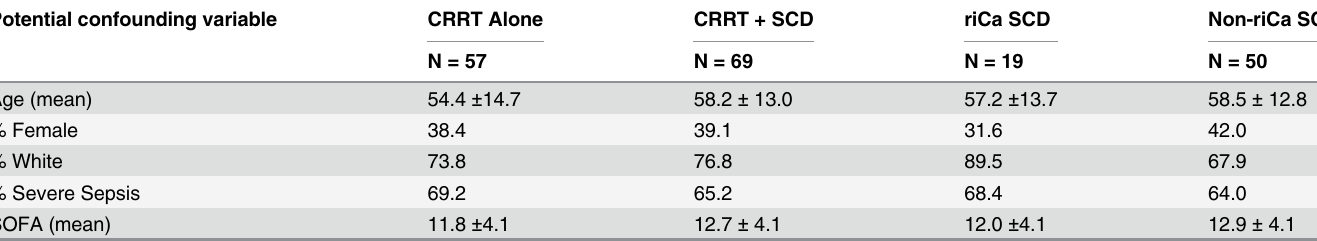
Table 7. Baseline characteristics of the riCa and non-riCa vs. control subset of patients.